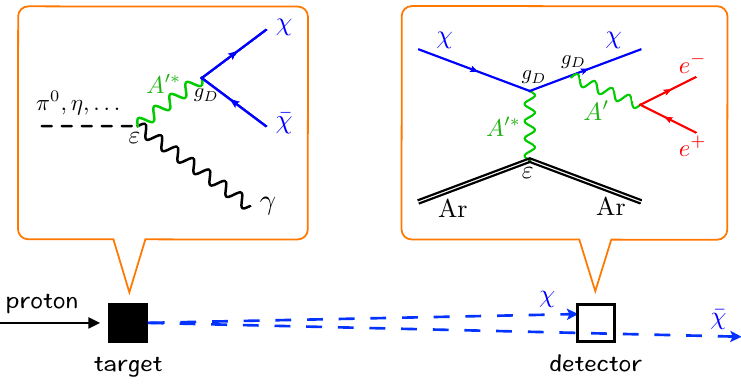
Figure 1 . Dark trident production in the benchmark dark sector model, described in the